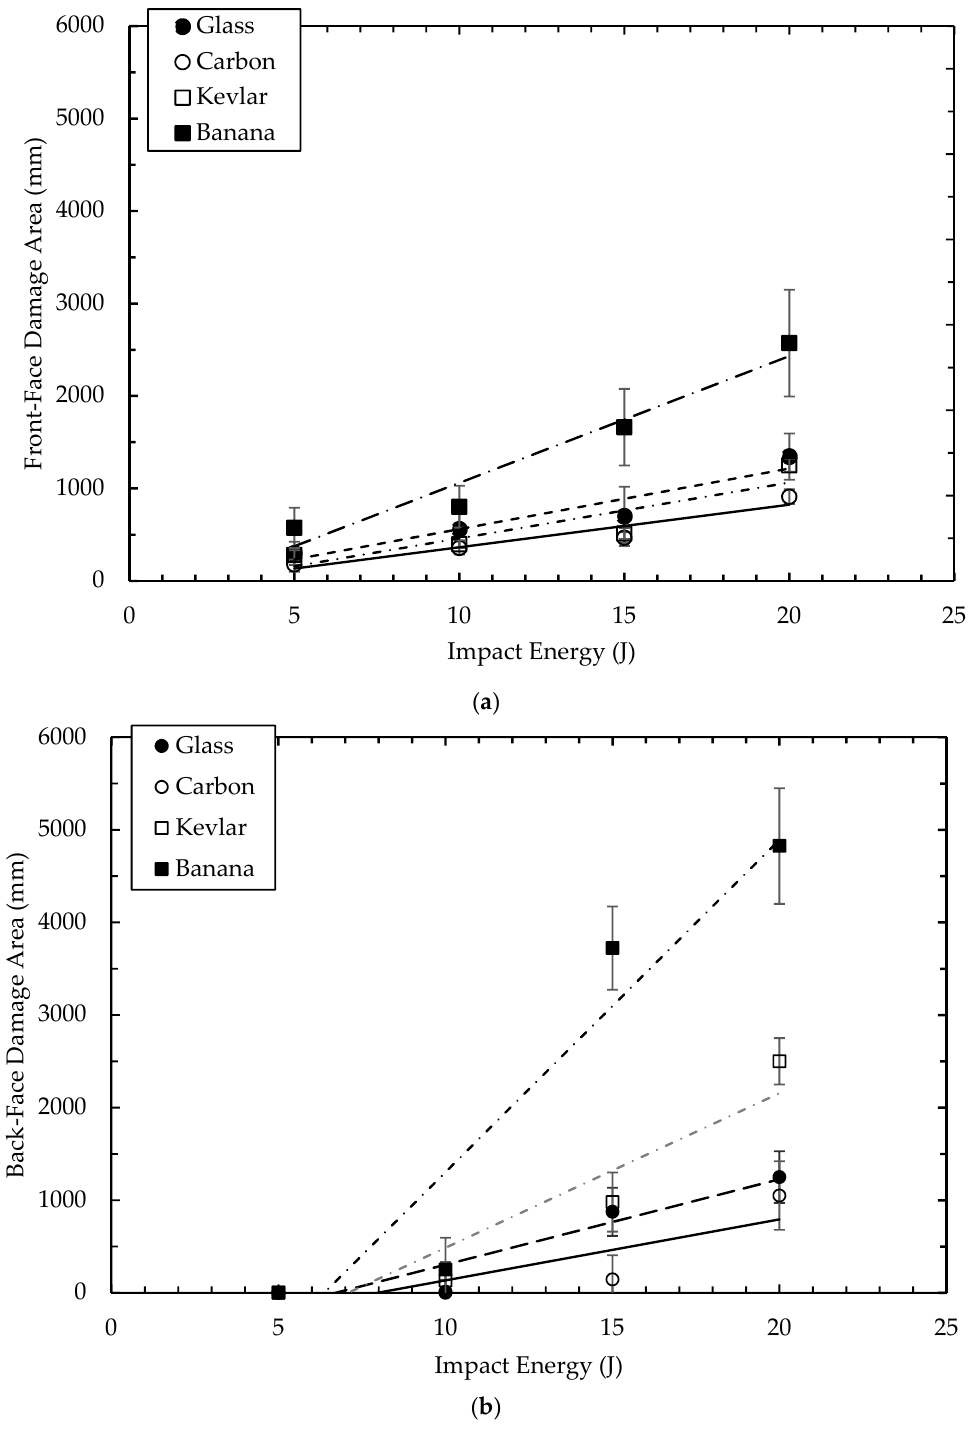
Figure 10. Nominal ( a ) front- and ( b ) back-face damaged areas versus incident impact energies.